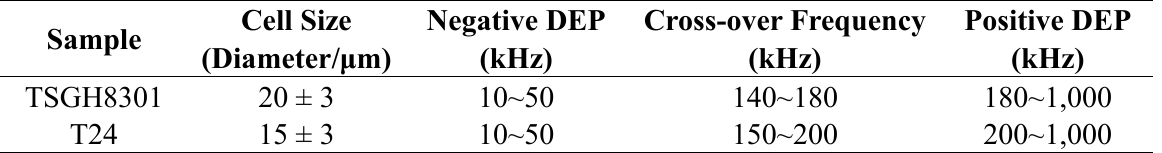
Table 3. Frequency range of negative DEP, positive DEP and cross-over frequency for TSGH8301 (grade II) and T24 (grade III) cells suspended in the